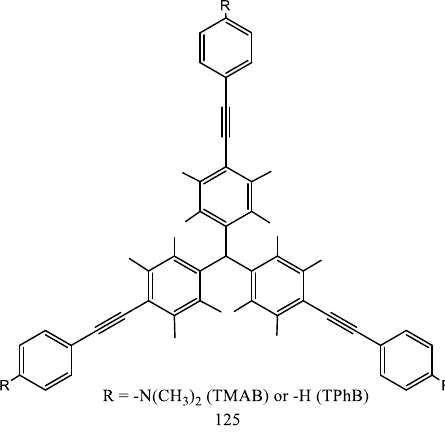
Figure 22. Structures of TMAB and TPhB.